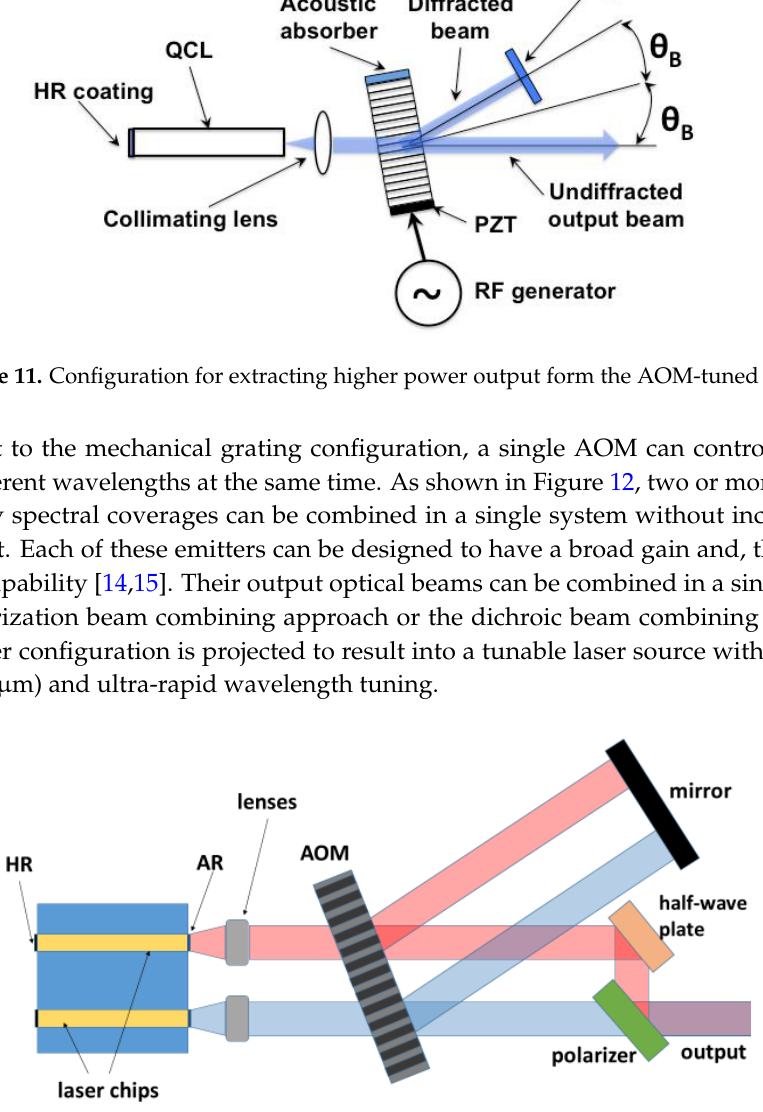
Figure 12. Dual-laser AOM-tuned QCL setup.